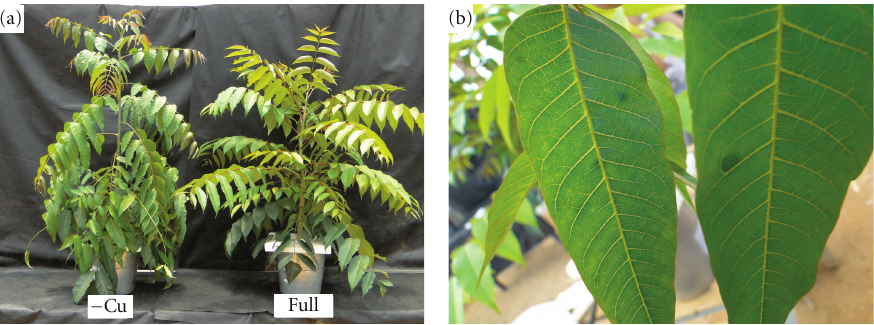
Figure 6: Symptoms of Cu deficiency in Australian Red Cedar seedlings. Wilt of leaves (a) and green-bluish punctuations on the leaflets